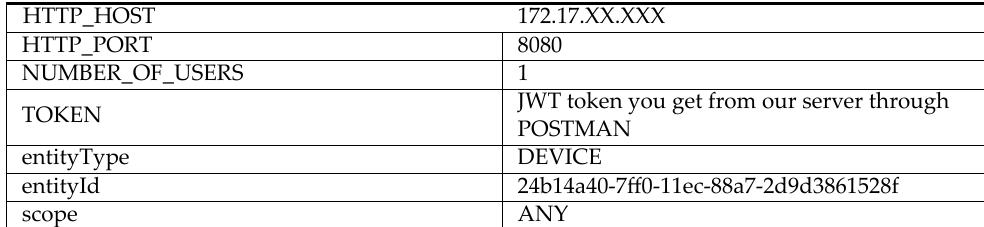
Table 5. Configuration for server request.